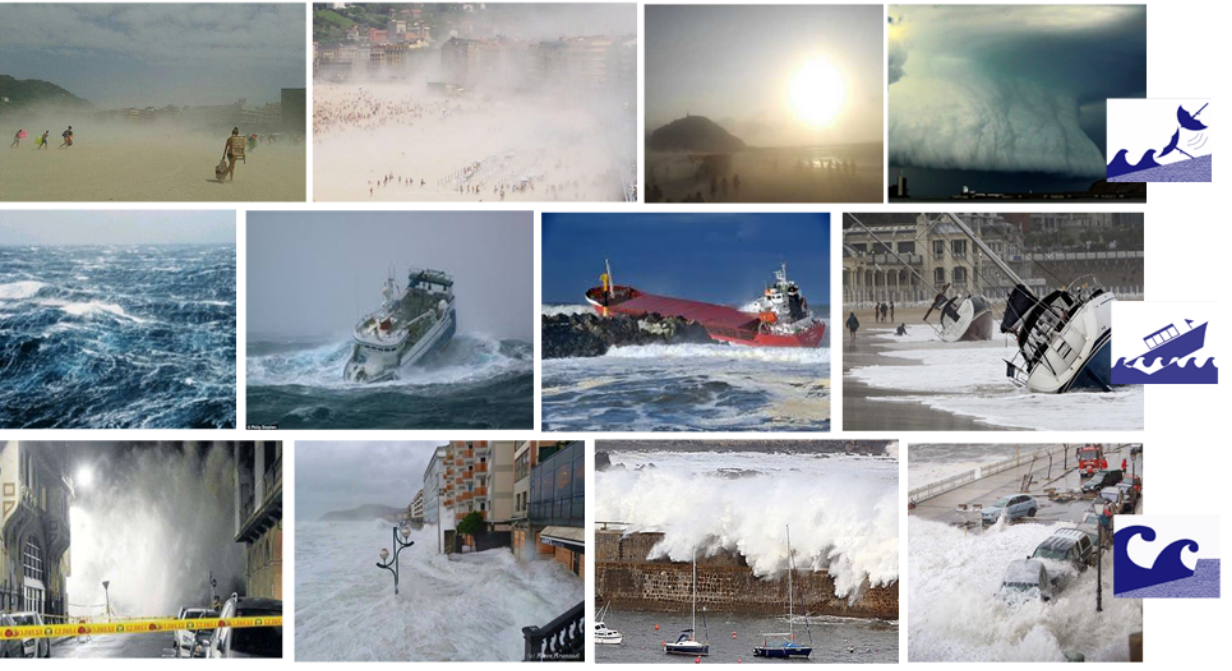
Figure 3. Some illustrative images from coastal–maritime hazards in Basque Country, from top to bottom panels: “galernas”, “navigation” and “littoral